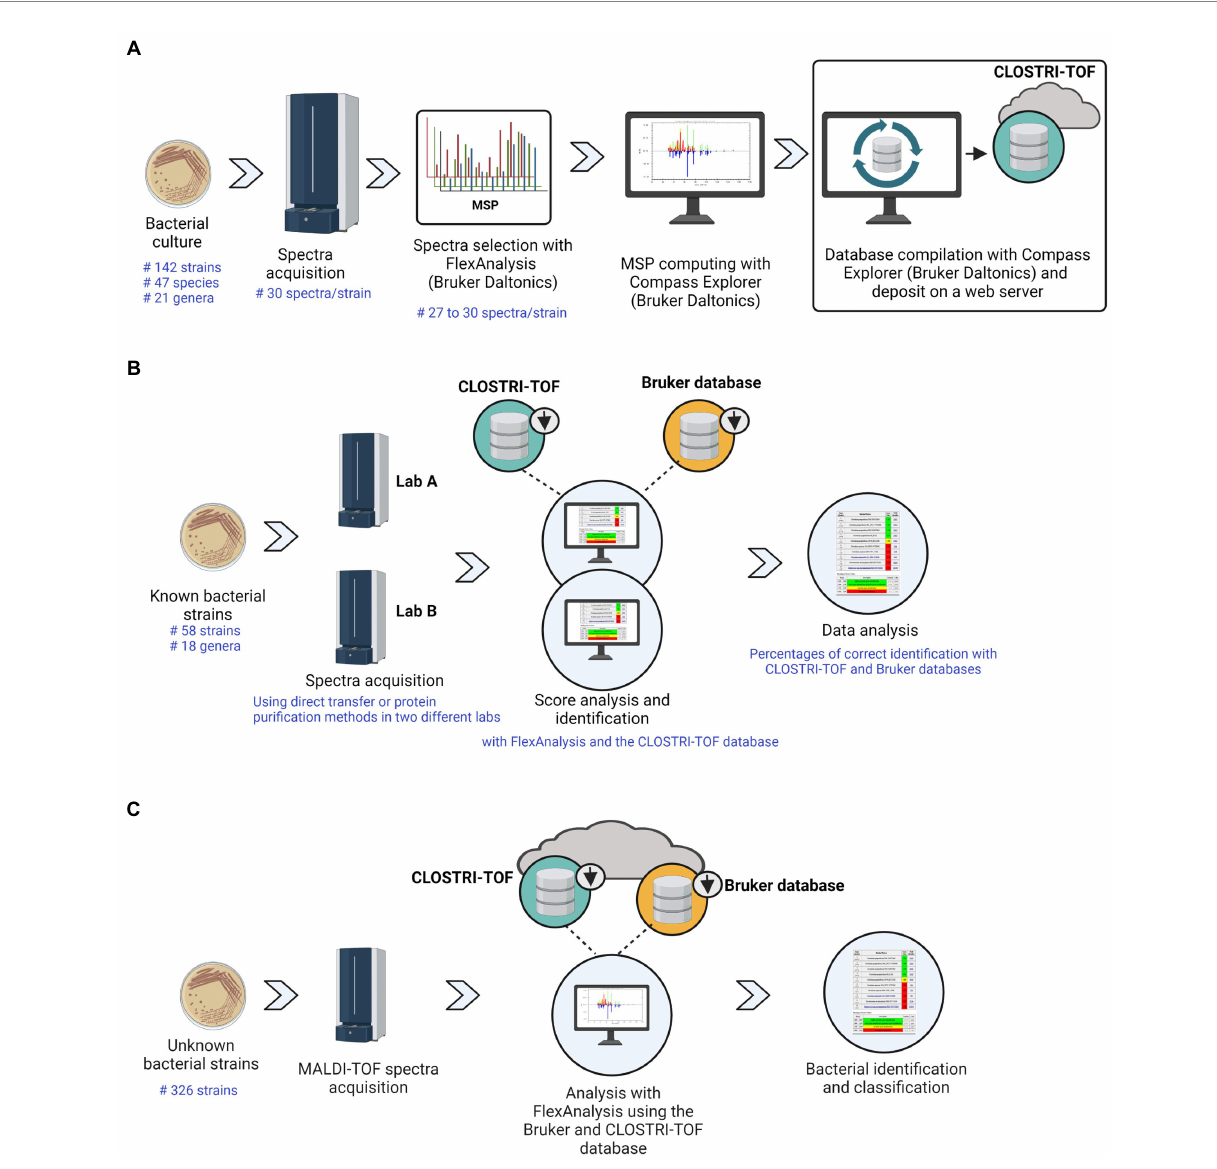
FIGURE 1 Main steps of CLOSTRI-TOF creation (A) , validation (B) , and MALDI-TOF MS microbial identification workflow (C)